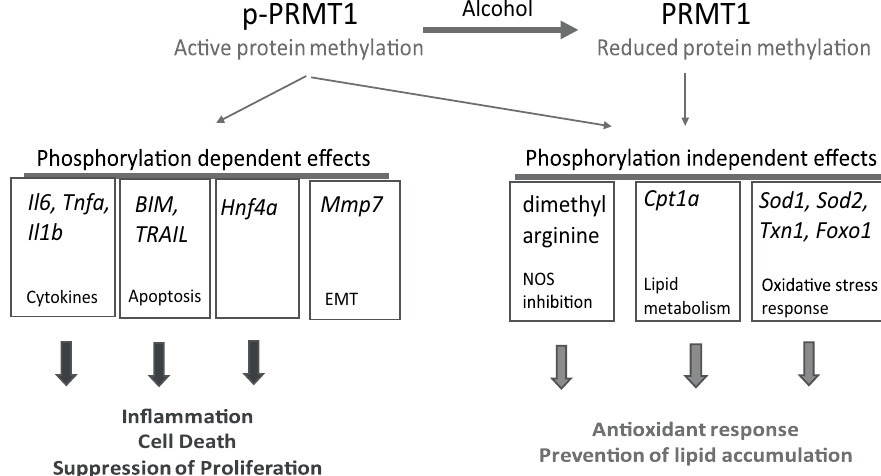
Figure 7. Model of PRMT1 activity shift in alcohol fed mice. There are two forms of PRMT1, the S297 phosphorylated form that predominates in the non-alcohol condition and a de-phosphorylated form that is generated after alcohol exposure. The phosphorylated form is more efficient in promoting the expression of cytokines, HNF4 α and MMP7, BIM and TRAIL expression. Phosphorylation independent functions include Cpt1 expression, ADMA generation and the antioxidant stress